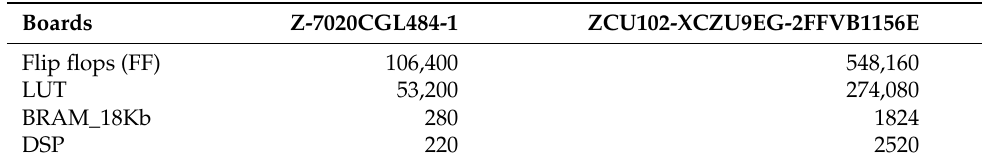
Table 3. Available resources onboard ZYNQ-7020 and ZCU102.